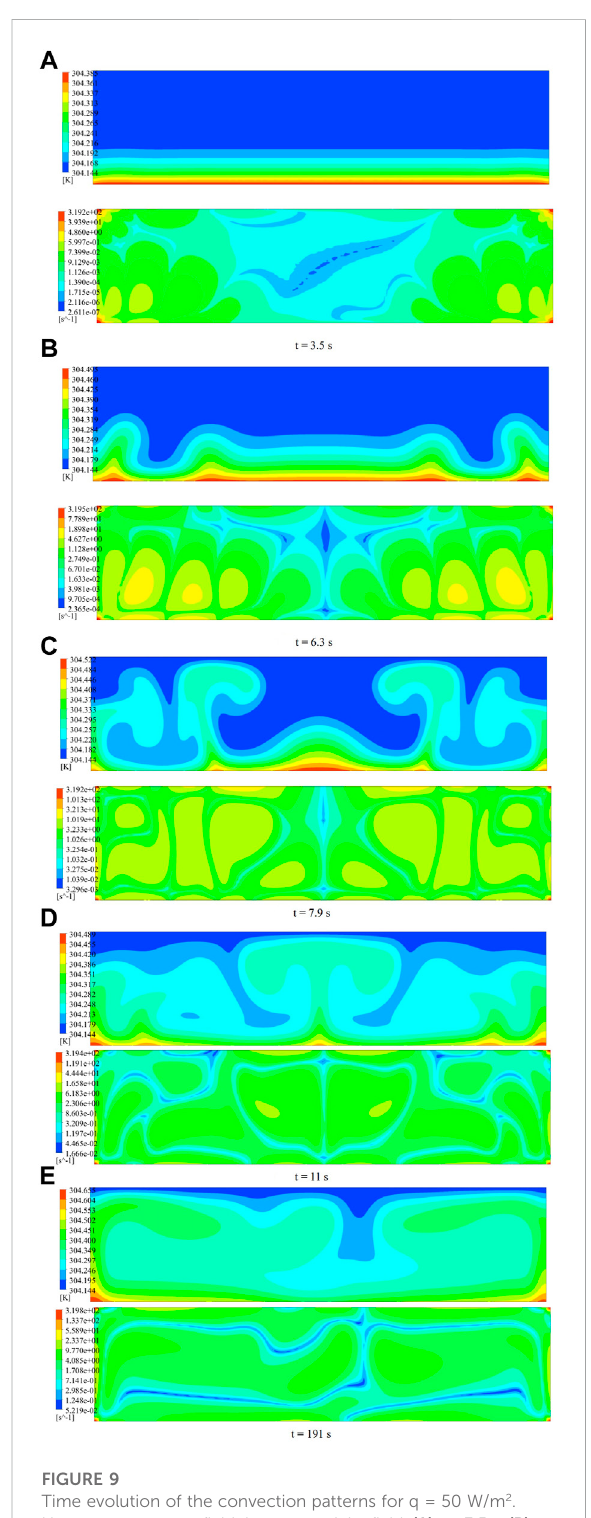
FIGURE 9 Time evolution of the convection patterns for q = 50 W/m 2 . Upper: temperature fi eld; Lower: vorticity fi eld. (A) t = 3.5 s. (B) t = 6.3 s. (C) t = 7.9 s. (D) t = 11 s. (E) t = 191